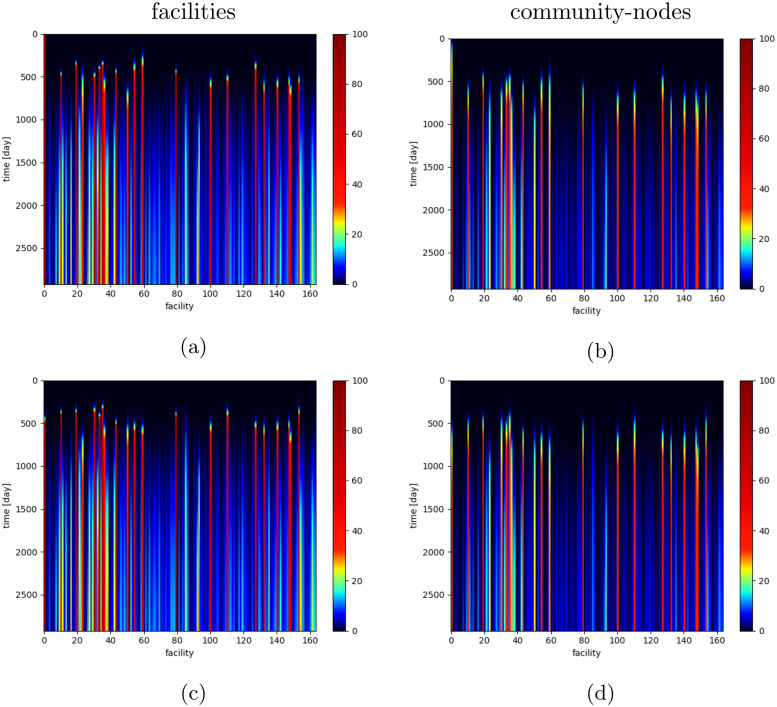
MRSA prevalence in the individual healthcare facilities and community-nodes.MRSA prevalence (over time) expressed as the percentage of infectious individuals per healthcare facility (a,c) and corresponding community-node (b,d). Deep blue corresponds to low infection proportions (lower than 5%); yellow or red to facilities with high infection proportions (higher than 20%). Healthcare facilities are ordered by average size, with the smallest first. The process was started by a single infectious patient located in facility number: (a,b) 1 (the smallest facility); (c,d) 164 (the biggest facility).